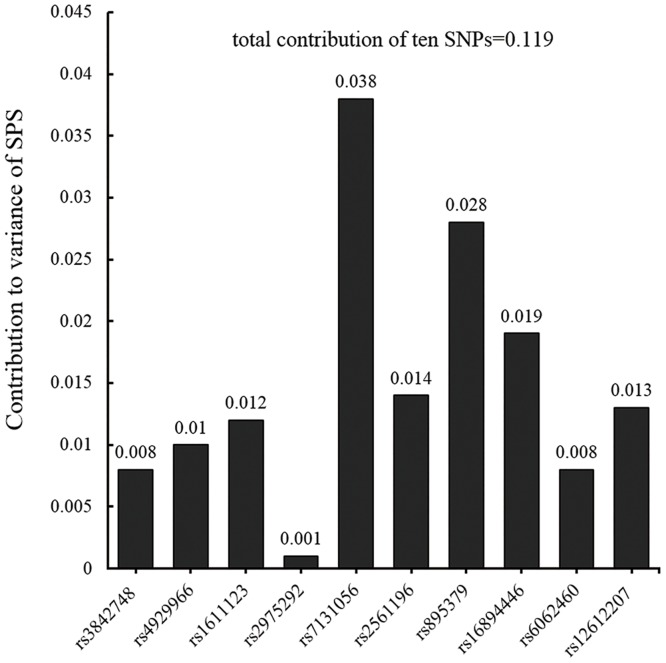
Contributions of identified dopamine-related SNPs to the variance of SPS.Each SNP was individually regressed to the score of SPS; for total contribution, all ten SNPs were simultaneously included in the regression analysis.